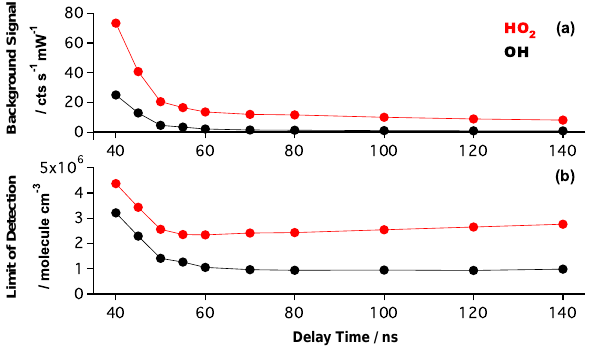
Fig. 7. Typical instrument performance for OH (black) and HO 2 (red) changes with the time interval between laser trigger and fluo- rescence collection. (a) Background signal (ctss − 1 mW − 1 ) and (b) Limit of Detection (moleculecm − 3